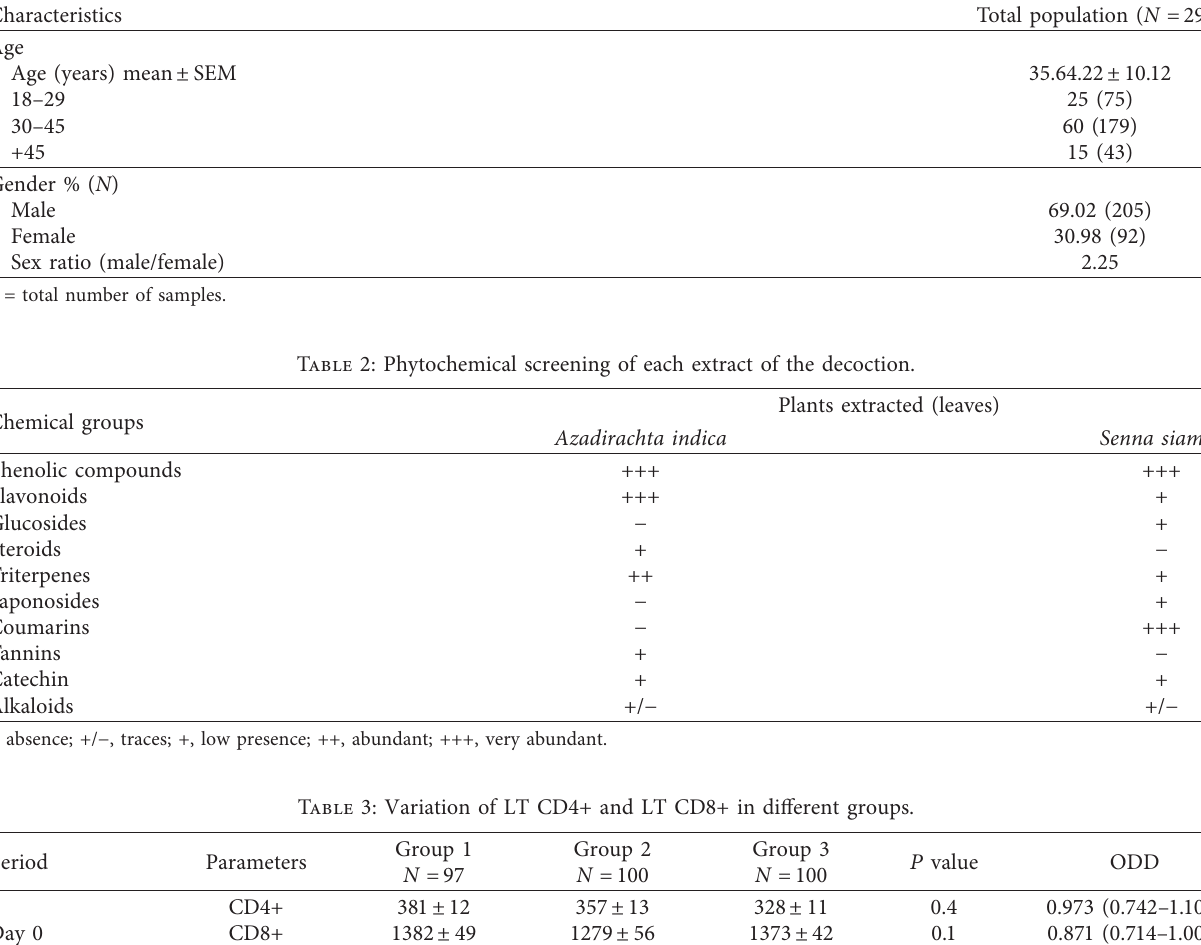
Table 1: Characteristics of the study population.